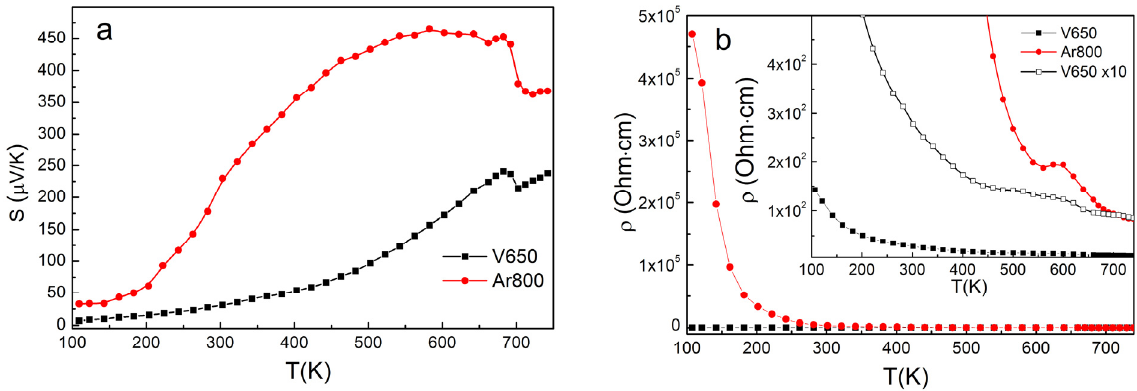
Figure 3. Temperature dependencies of the Seebeck coefficient ( a ) and electrical resistivity ( b ) for compressed CuCrS 2 samples. The inset shows the enlarged curves.